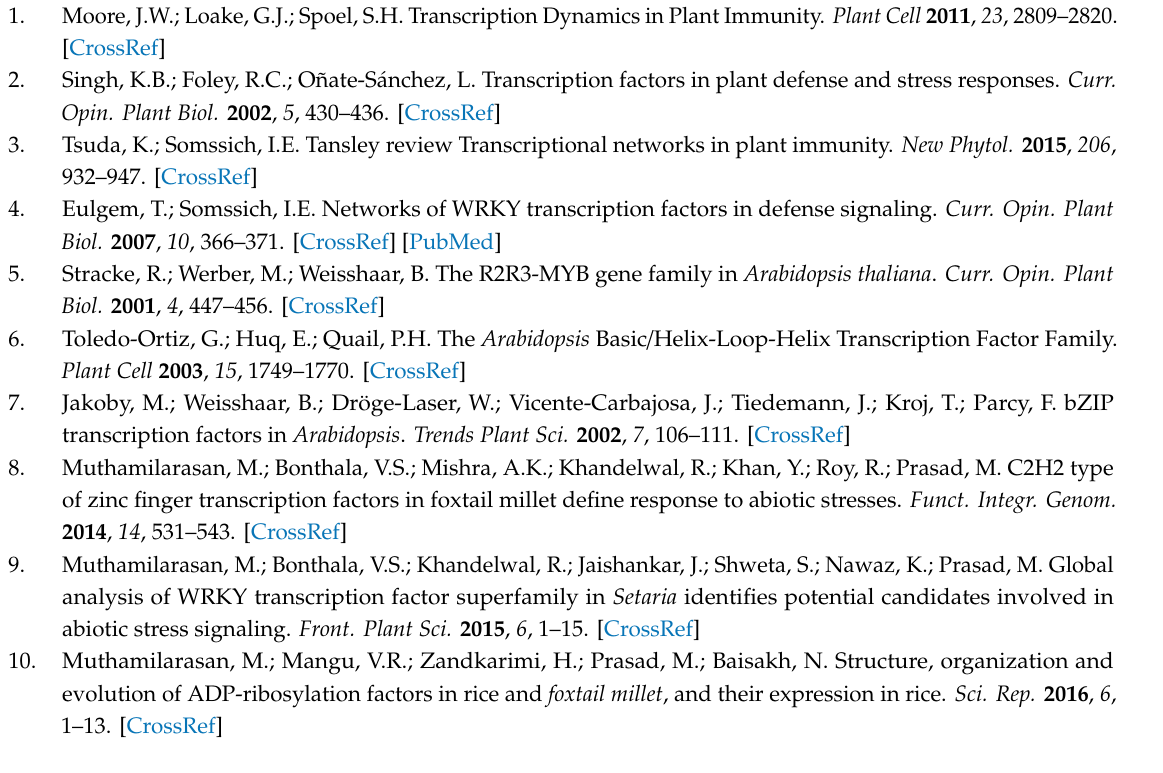
Supplementary Materials: The following are available online at http: // www.mdpi.com / 1999-4915 / 11 / 5 / 419 / s1, Figure S1 Phylogenetic relationships and architecture of conserved protein motifs in hop TF genes. The phylogenetic tree was constructed based on the full-length sequences of hop TF proteins using MEGA 7 software. The motifs numbers 1–10, are displayed in di ff erent colored boxes and sequence information of the motifs are presented in the adjacent box. The sequence information for each motif is provided in the boxes. Table S1 : List of qRT-PCR primers used for the validation of expression profiles of selected hop TFs. Table S2 : Details of NCBI blast hits of CBCVd-responsive hop TFs. Table S3 : Description of protein properties and predicted subcellular localization of CBCVd-responsive hop TFs. Table S4 : Digital expression profiles of CBCVd-responsive hop TFs derived from FPKM values. Table S5 : List of CBCVd-responsive hop TF orthologous genes in Arabidopsis thaliana . Table S6 : Description of putative functions of proteins interacting with the CBCVd-responsive hop TFs identified in this